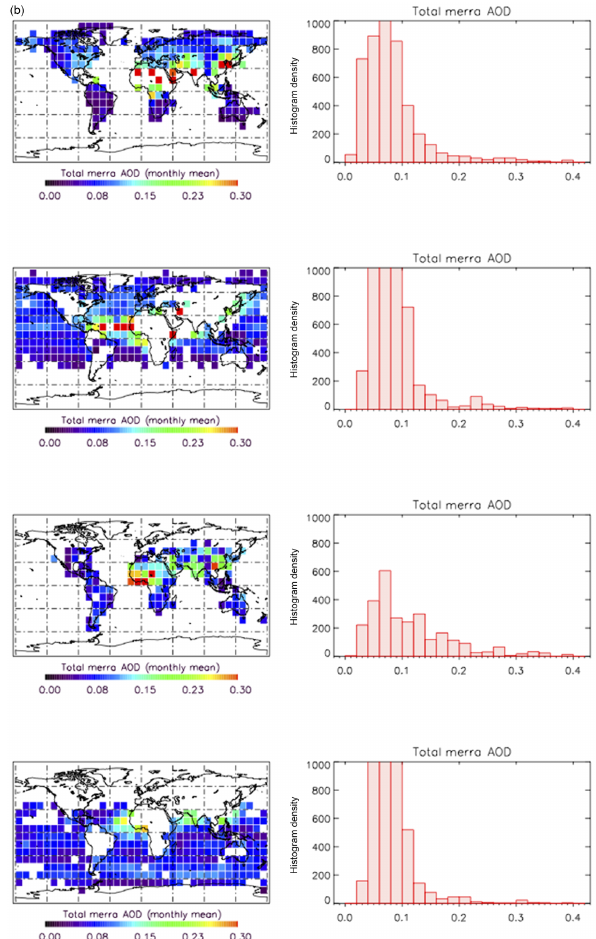
Figure 4. (b) Monthly mean aerosol optical depth (AOD) from MERRA. Top: June, land; second row: June, ocean; third row: Dec., land; bottom: Dec.,